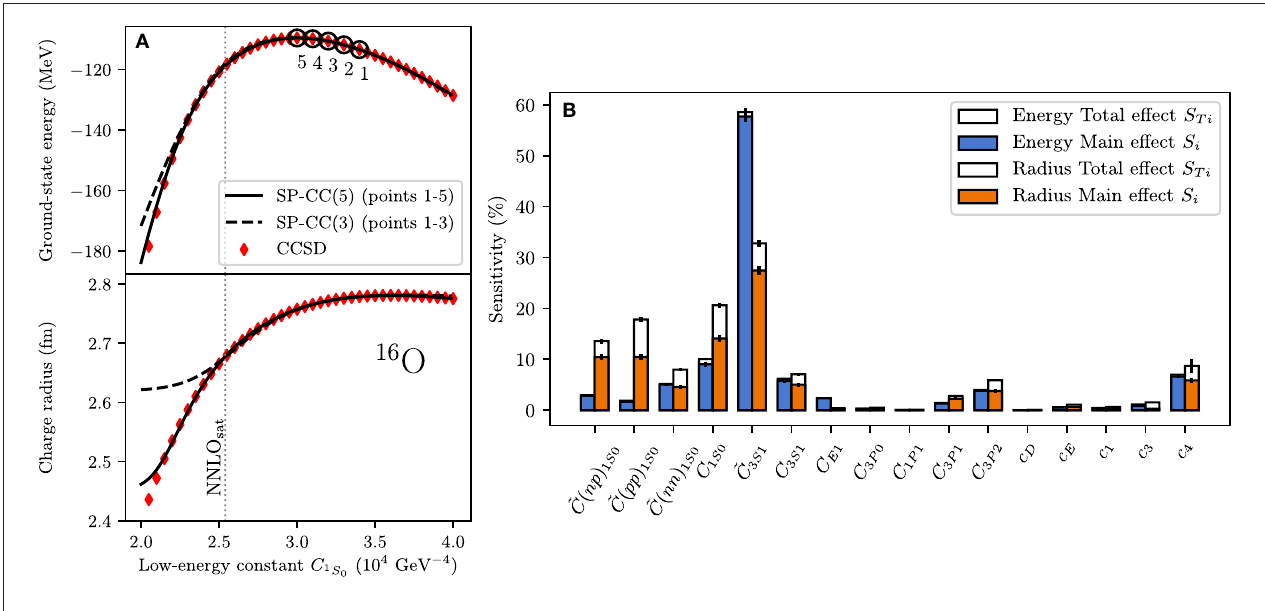
FIGURE 15 | Sensitivity analysis using subspace-projected CC (SPCC) method [281]. (A) illustrates the capability of the SPCC Hamiltonian constructed from 3 to 5 sample points to predict full CCSD ground-state energies and charge radii for 16 O over a wide range of values of the chiral LEC C 1 S of the 16 O ground-state energy and charge radius to chiral LECs, determined by evaluating over 1,000,000 quasi-MC samples from a 64-dimensional SPCC Hamiltonian. Vertical bars indicate 95 % confidence intervals. For details, see reference [281]. Figure reprinted with permission from the American Physical